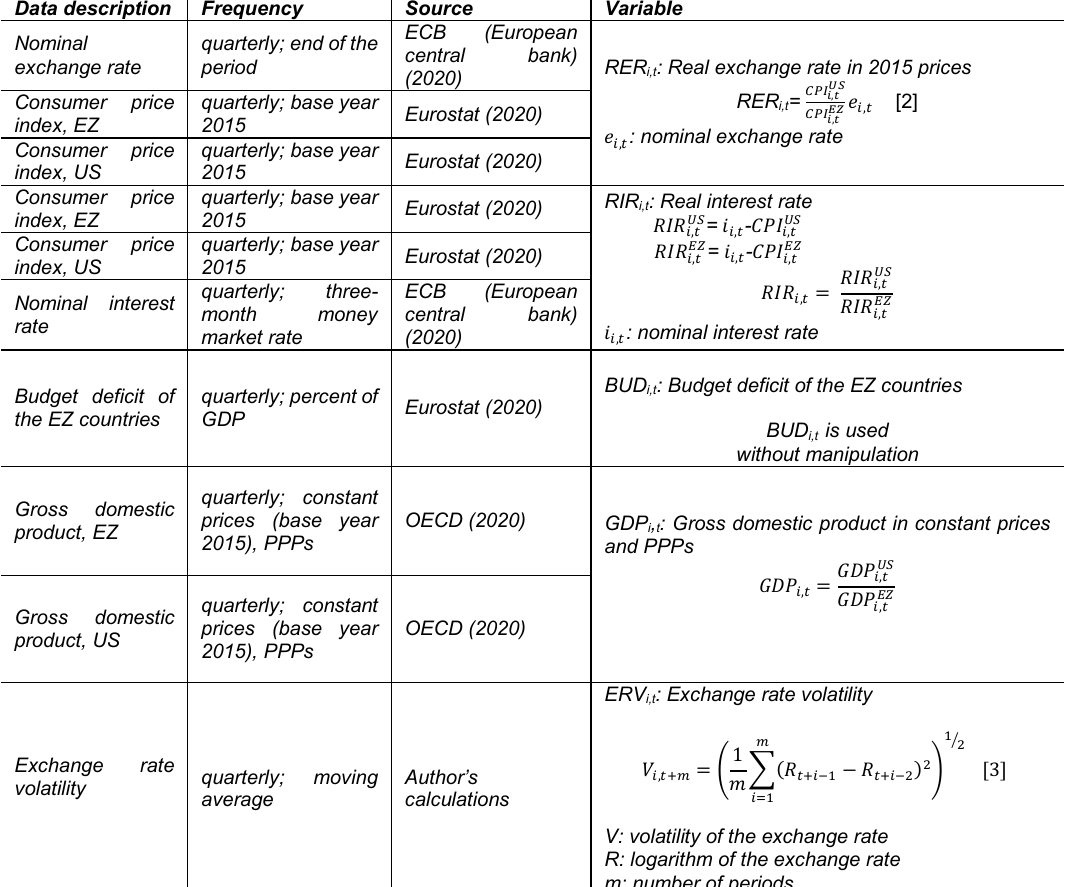
Table 1. Data sources and construction of the